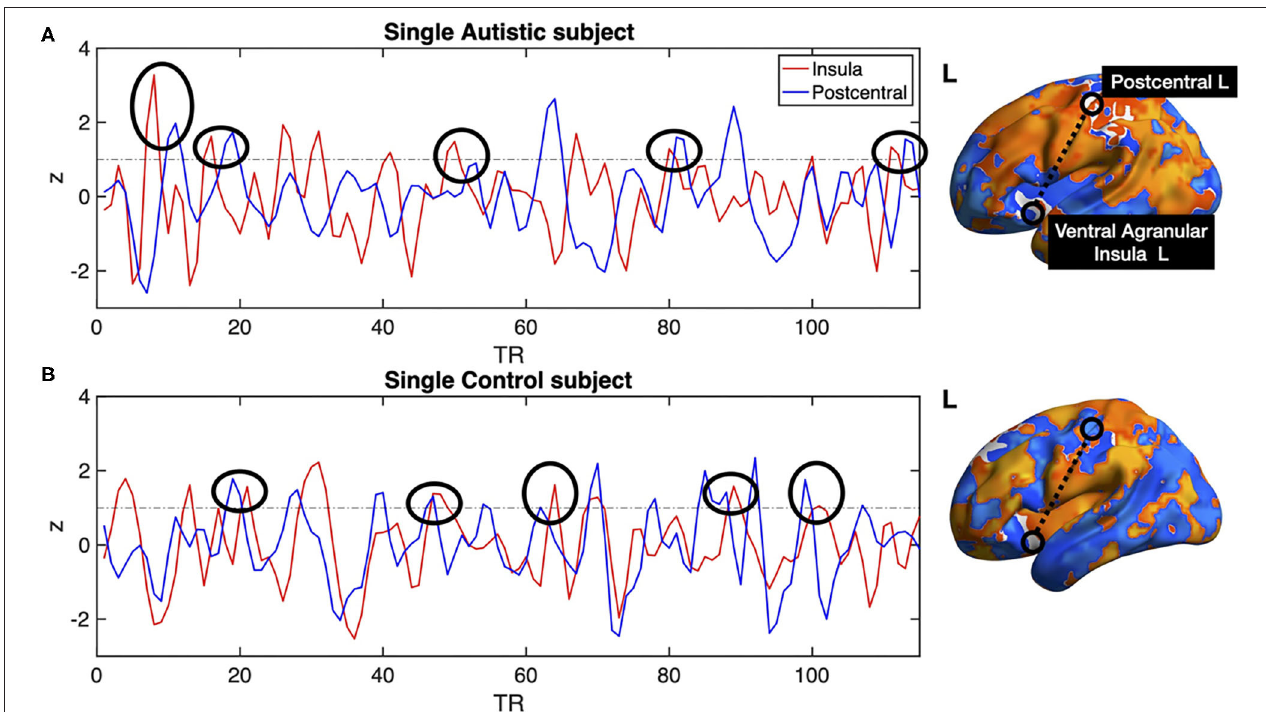
FIGURE 8 | Single subject postcentral gyrus (blue lines) and ventral agranular insula (red lines) BOLD time series. (A) shows example data from an AU, (B) shows data from a HS. Black circles show several instances in which the delays between the time series are consistent with the statistics compiled from the entire groups shown in Figure 7 . The example shows that the insular events on the AU patient are usually preceding the postcentral events, resulting in a negative delay, while the opposite results are observed on the BOLD time series of the Healthy